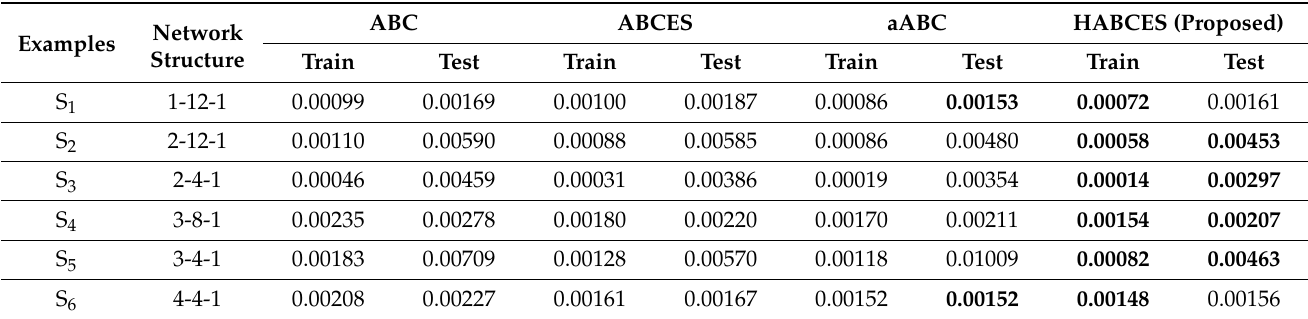
Table 7. Comparison of the results of the ABC, aABC, ABCES and HABCES algorithms for nonlinear static system identification.